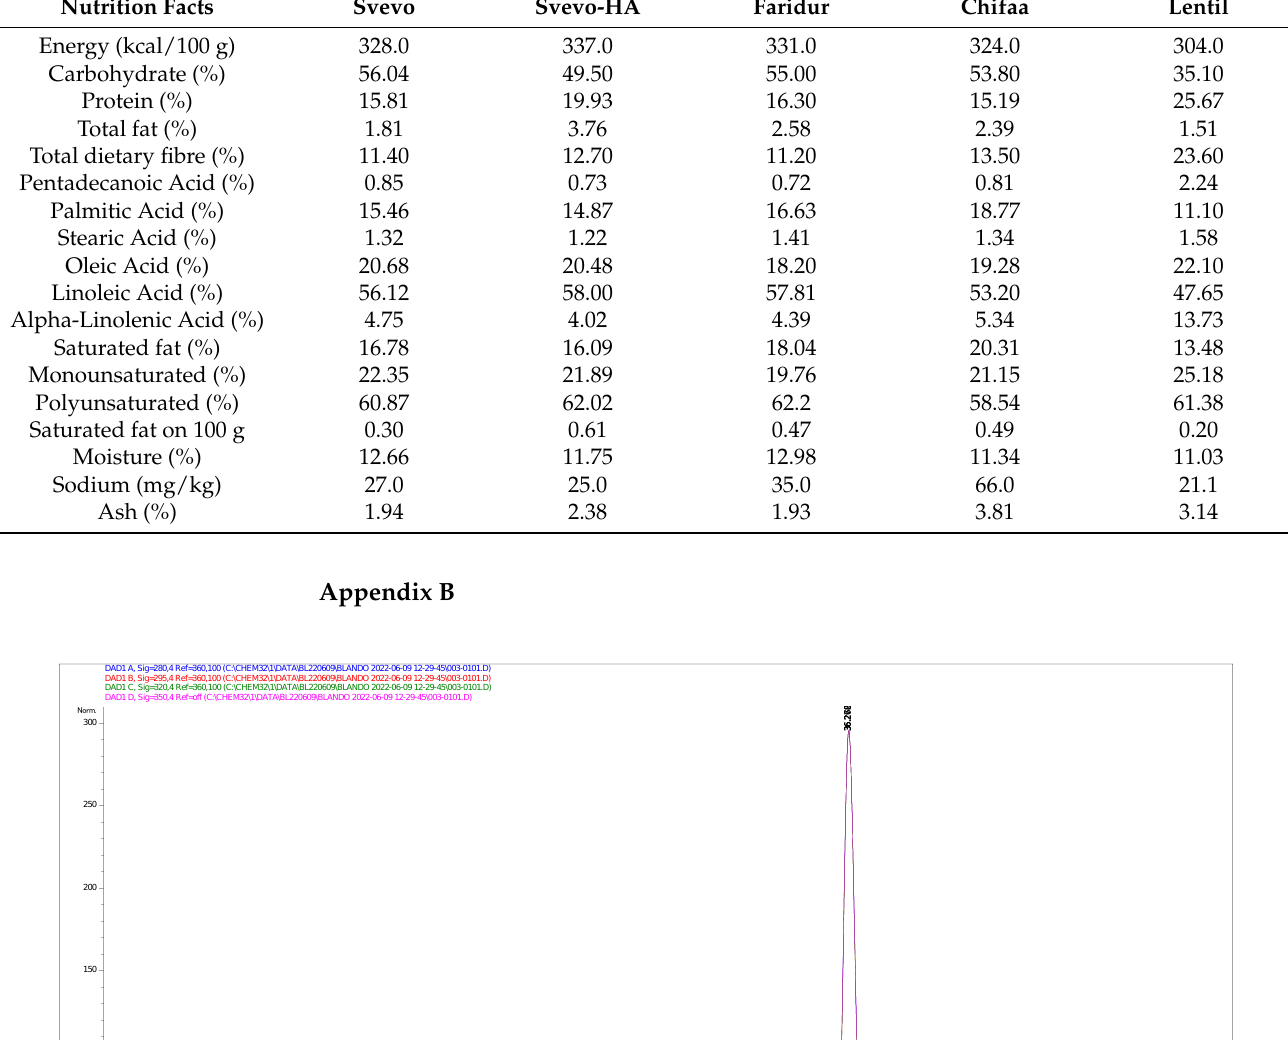
Table A1. Nutrition information of Svevo, Svevo-HA, Faridur, Chifaa and lentil 6002/ILWL118/1-1 wholemeals (Average values provided by Bonassisa Lab Srl, Foggia, Italy).